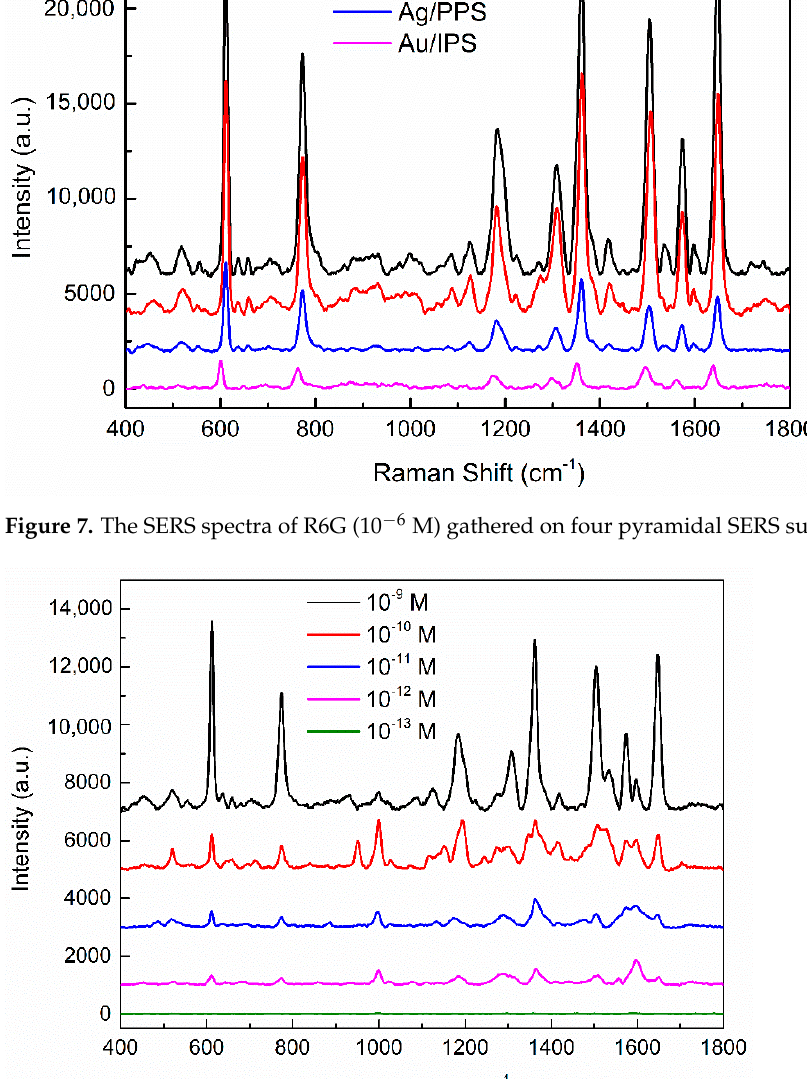
Figure 9. The histogram with errors of the average peak of R6G solution (ranging from 10 (cid:2879)(cid:2877) M to 10 (cid:2879)(cid:2869)(cid:2870) M) at 611 cm (cid:2879)(cid:2869) . Finally, the stability of SERS substrate is very important. The SERS spectrum was measured again for the Ag/IPS soaked in R6G solution with a concentration of 10 (cid:2879)(cid:2874) M and it was stored it in a 4-inch silicon wafer box and sealed at room temperature for three years. Figure 10 shows the SERS spectrum of the Ag/IPS, the red line is the Raman spec- trum after preparation, while the black line is the Raman spectrum of the same substrate after three years. Three years later, the intensity of the Raman peak at 611 cm (cid:2879)(cid:2869) was 29% of that of the initial result, which indicates that the proposed pyramidal SERS substrate has a good stability.